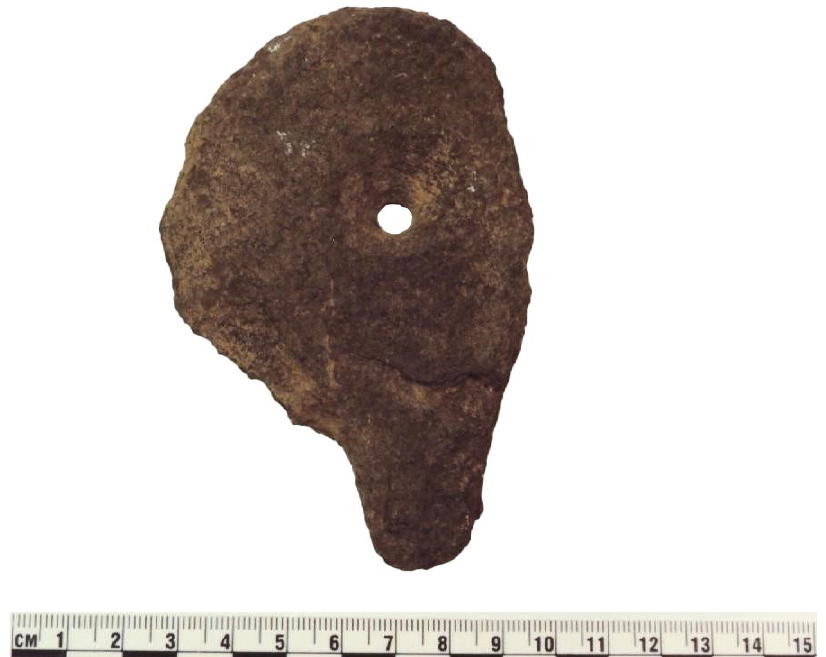
Figure 8. Photograph of Rounded variety fragment with bi-conical drill hole through the blade (by Healy, courtesy of Cambridge University Museum of Archaeology and Anthropology, Cat. No. 1946.166D; scale in